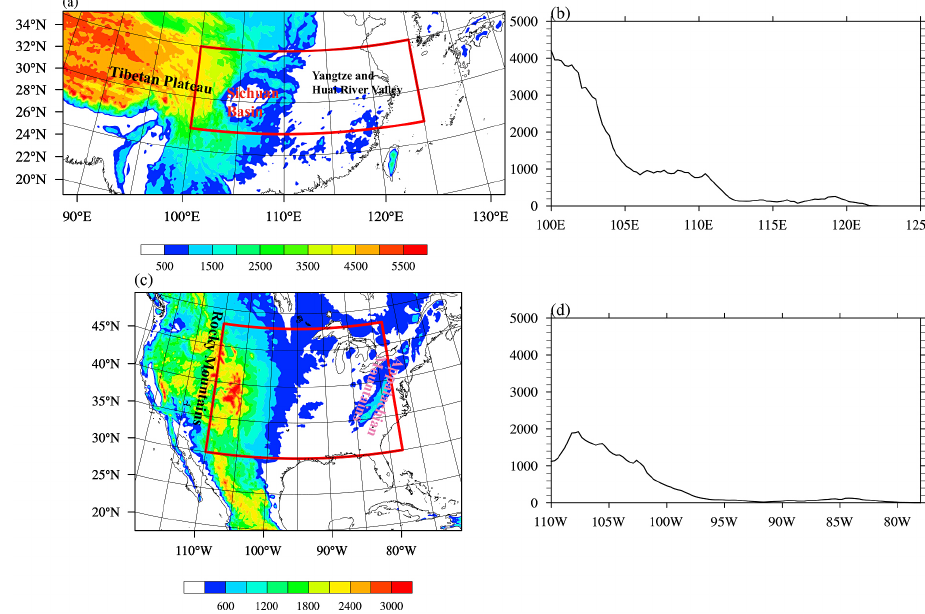
Figure 1. Map distributions of the terrain elevations over (a) East Asia and (c) North America with the red boxes denoting the focus domains (shadings, units: m). The right panels are the meridional averages of the terrain elevations over the focus domains for (b) East Asia and (d) North